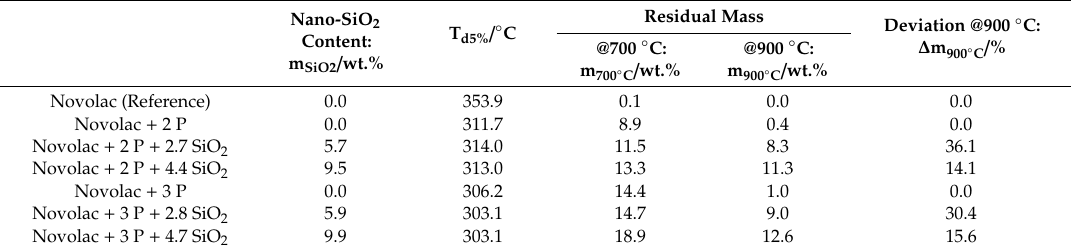
Table 6. Td5%, residual mass @700 °C and @900 °C from TGA curves and deviation according to equitation 2.